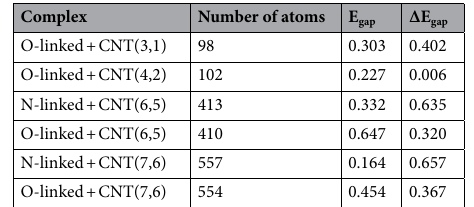
Table 2. Number of atoms in the simulation super cell for CNT + glycan complexes, the corresponding electronic band gaps, Egap, in eV, and the variation in band gap, ∆Egap, compared to pristine CNT.